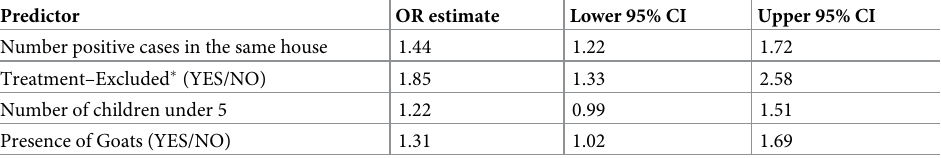
Table 3. Odds ratios (OR) associated with selected variables from generalised linear mixed model for risk of being a super-spreader house. � If yes, the village has the same interventions as the control village but it is excluded from the trial analysis because of proximity to other